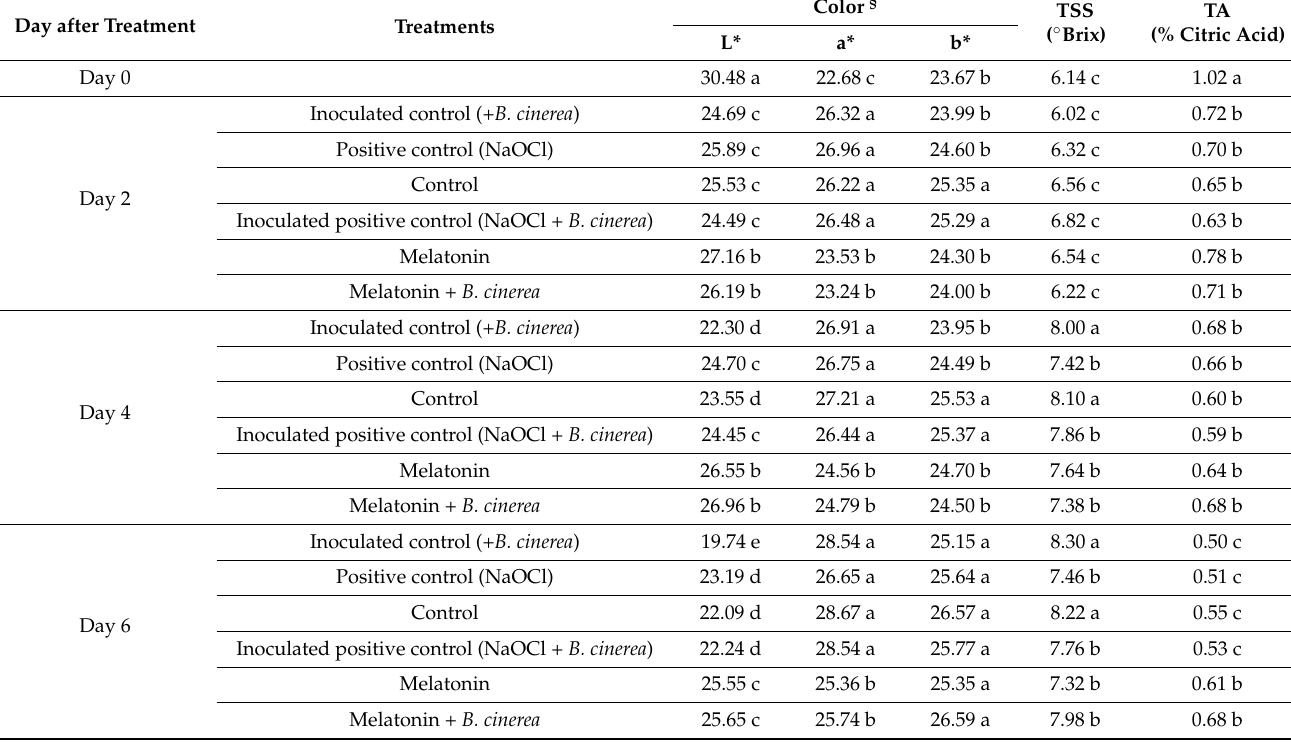
Table 1. Effects of melatonin on fruit color and other physicochemical qualities (total soluble solids, TSS; total titratable acidity, TA) of strawberry fruits treated with exogenous melatonin, and inoculated with or without Botrytis cinerea during a six-day storage at room temperature (25 ± 2 ◦ C, 80–85%